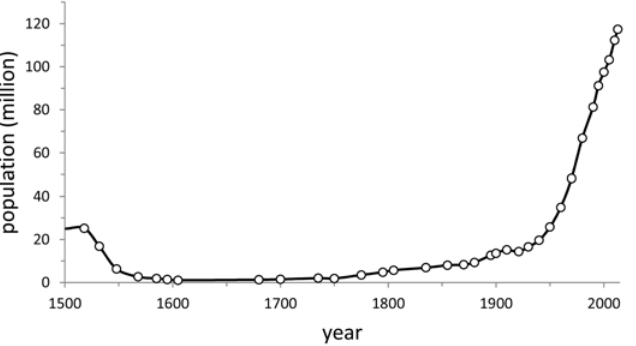
Fig 6. Population in Mexico between 1521 and present. Data compiled from Borah and Cook 1969, McCaa 2000, Benítez Zenteno 1961, and official population censuses available at